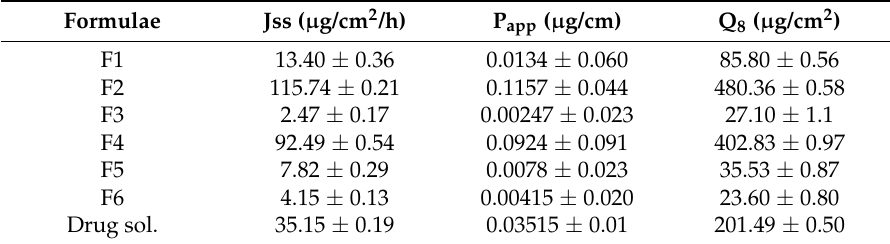
Table 3. Transcorneal permeation parameters of different formulae, n =